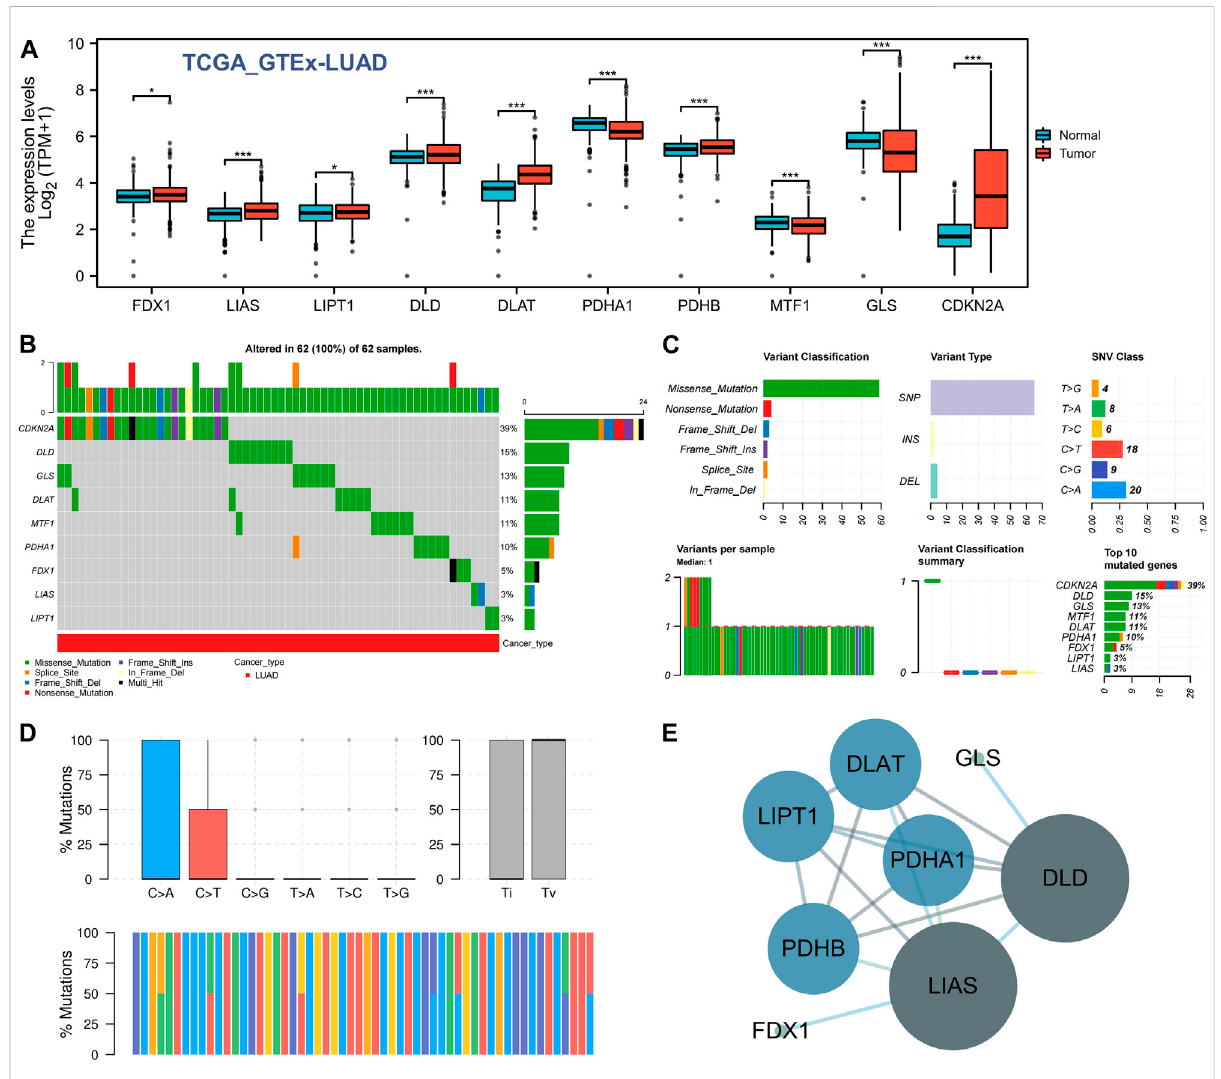
FIGURE 1 Expression difference and gene mutation of CRGs in LUAD. (A) Expression differences of 10 CRGs in LUAD and normal lung tissues. *, p < 0.05; ***, p < 0.001. (B,C) Gene mutation and classi fi cation of 10 CRGs in LUAD. (D) Transition (Ti) and transversion (Tv) classi fi cation of the SNVs of 10 CRGs in LUAD. (E) Interactive network of CRGs; the darker the color is, the larger the circle is, indicating that it belongs to the central target in the whole